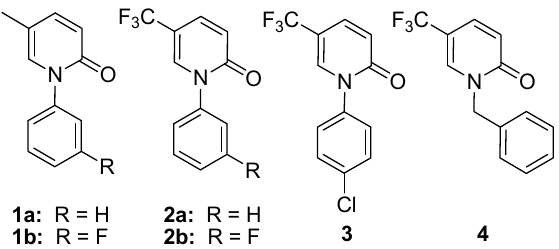
Figure 1. Structures of Pirfenidone and